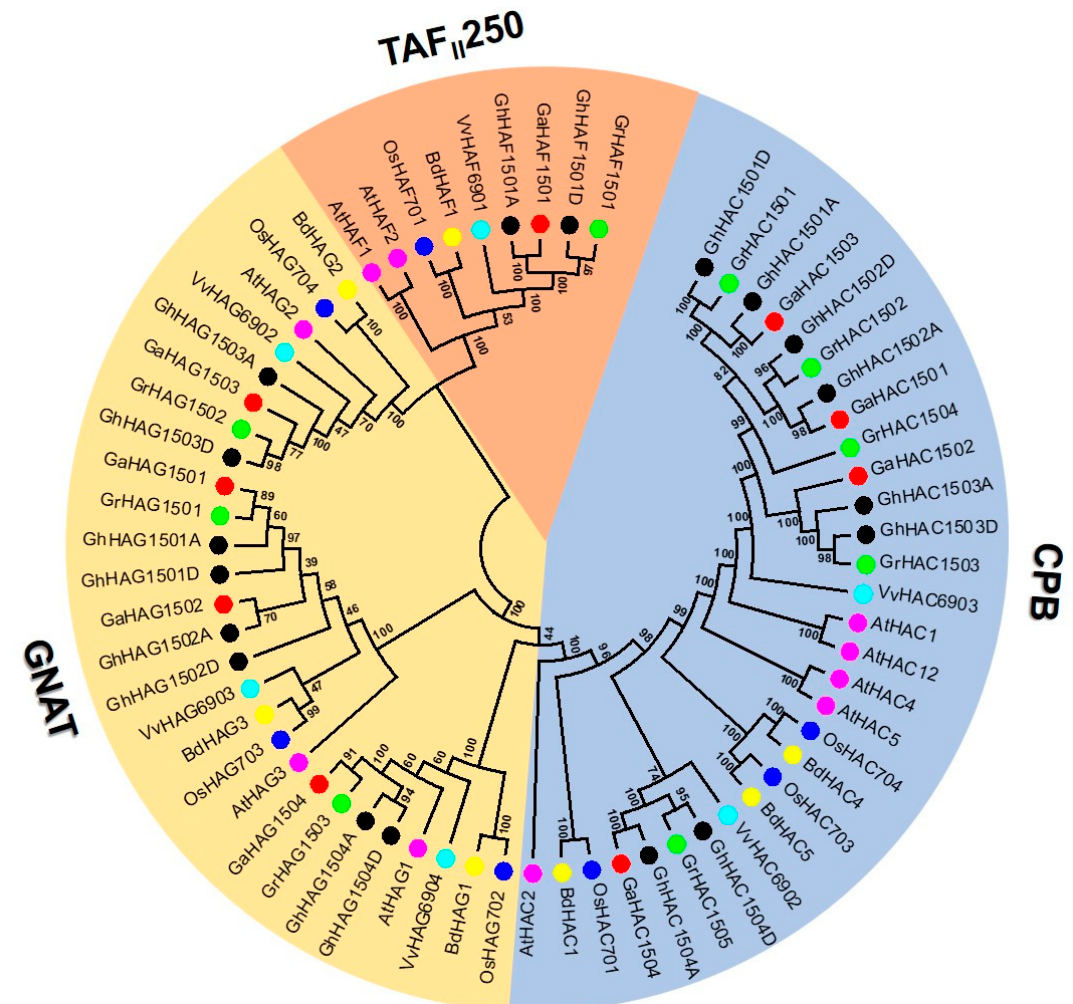
Figure 1. Phylogenetic relationships of histone acetyltransferases (HATs) from Gossypium hirsutum , Gossypium raimondii , Gossypium arboretum , Arabidopsis thaliana , Oryza sativa , Brachypodium distachyon and Vitis vinifera . The un-rooted phylogenetic tree was constructed using MEGA 6 by the neighbor-joining (NJ) method, and the bootstrap analysis was performed with 1000 replicates. For the phylogenetic tree, amino acid sequences were used and the classification of CPB, GNAT and TAF II 250 was performed based on the conserved signature domain of each subgroup. The HATs from G. hirsutum , G. raimondii , G. arboretum , Arabidopsis , V. vinifera , Brachypodium distachyon , and Oryza sativa were marked with black, green, red, pink, cyan blue, yellow, and blue dots, respectively.